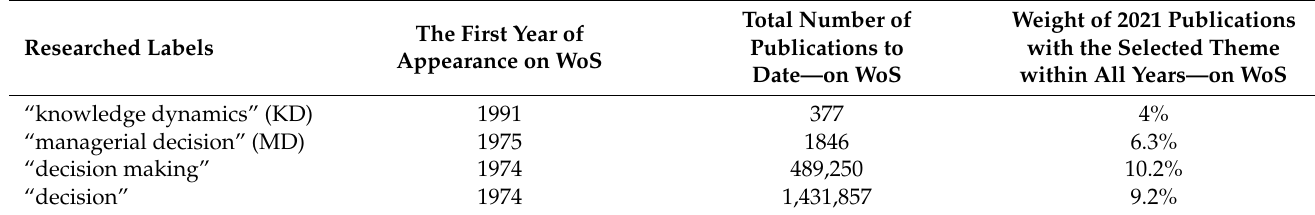
Table 1. Main concepts frequencies and weight on WoS (Source: authors’ own